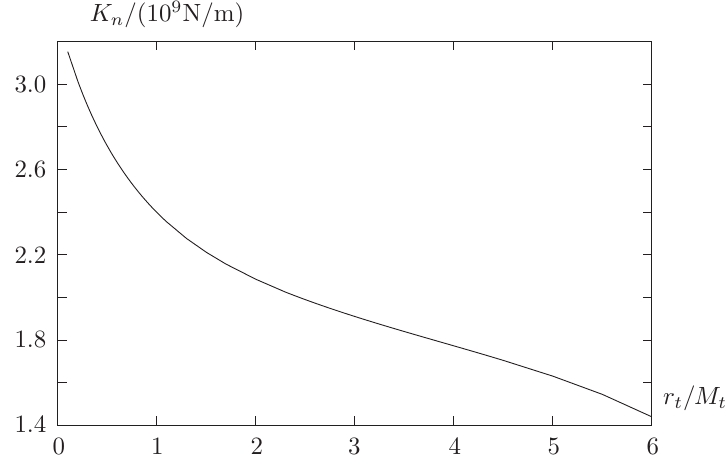
Figure 14: Helical tooth stiffness as a function of the rim thickness.